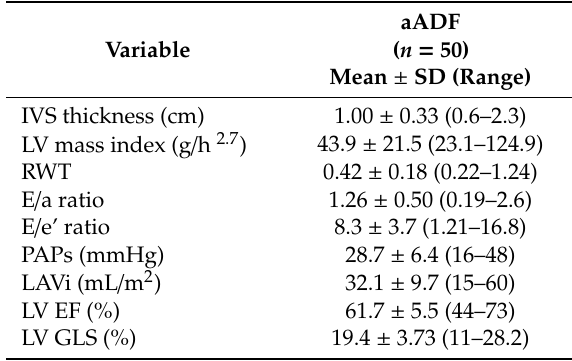
Table 2. Standard and speckle tracking echocardiography data of the study